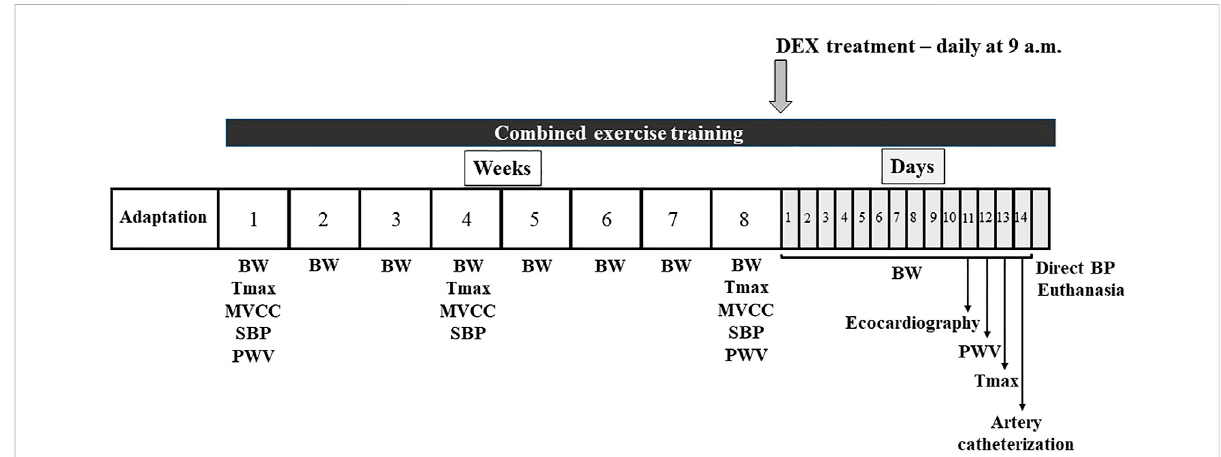
FIGURE 1 Illustration of the experimental design for 74 days. Adaptation period (5 – 10 days), body weight (BW), aerobic maximal capacity test (Tmax), maximal carrying capacity test (MVCC), systolic blood pressure (plethysmography) and pulse wave velocity (PWV) were measured throughout the experimental protocol. Combined training was performed during all 74 days. Dexamethasone (DEX) treatment during the last 14 days. At the end of the experimental protocol, echocardiographic and hemodynamic analyses were performed before